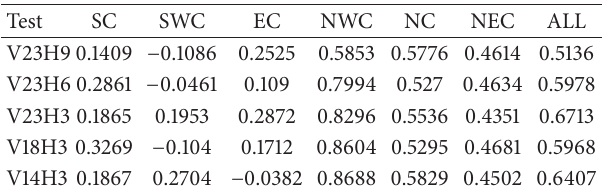
Table4:SpatialcorrelationcoefficientsofprecipitationfromtheL23 and X3 Schemes for the studied